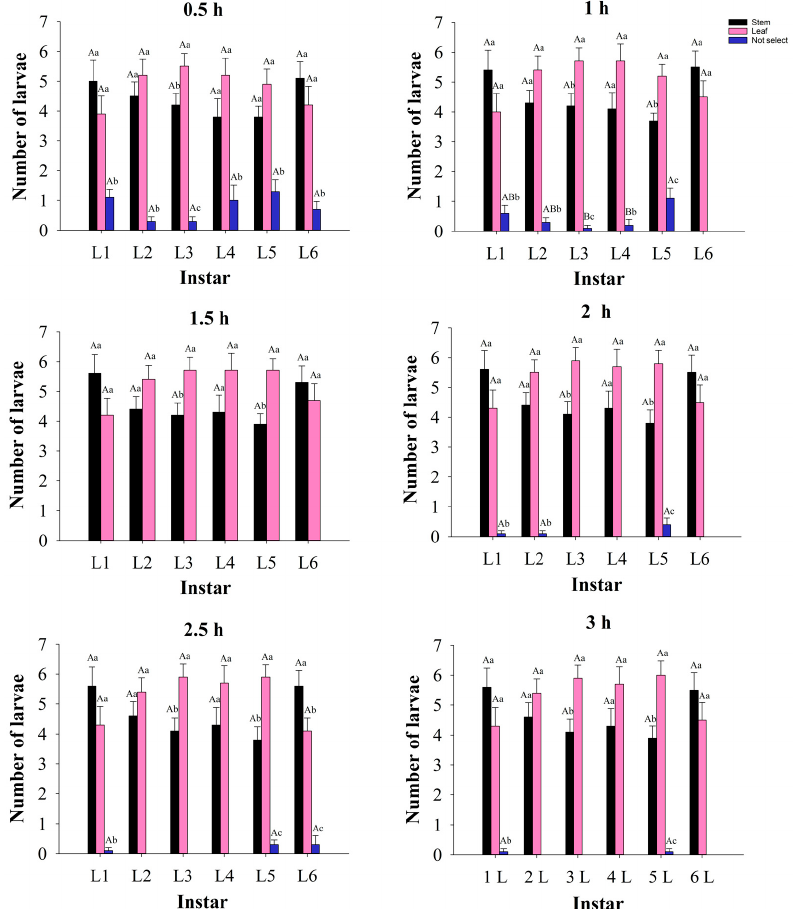
Figure 7. Feeding preference of each larvae stage of S. litura between asparagus stems and leaves. Values are mean ± SE, different lowercase letters at the same investigation time indicate that the same instar larvae are significantly different between different tissues, and different capital letters indicate that the different instar larvae are significantly different between the same tissues ( p < 0.05).